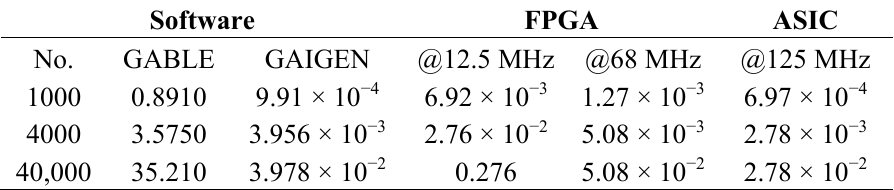
Table 3. Comparison of different Software and the proposed hardware.